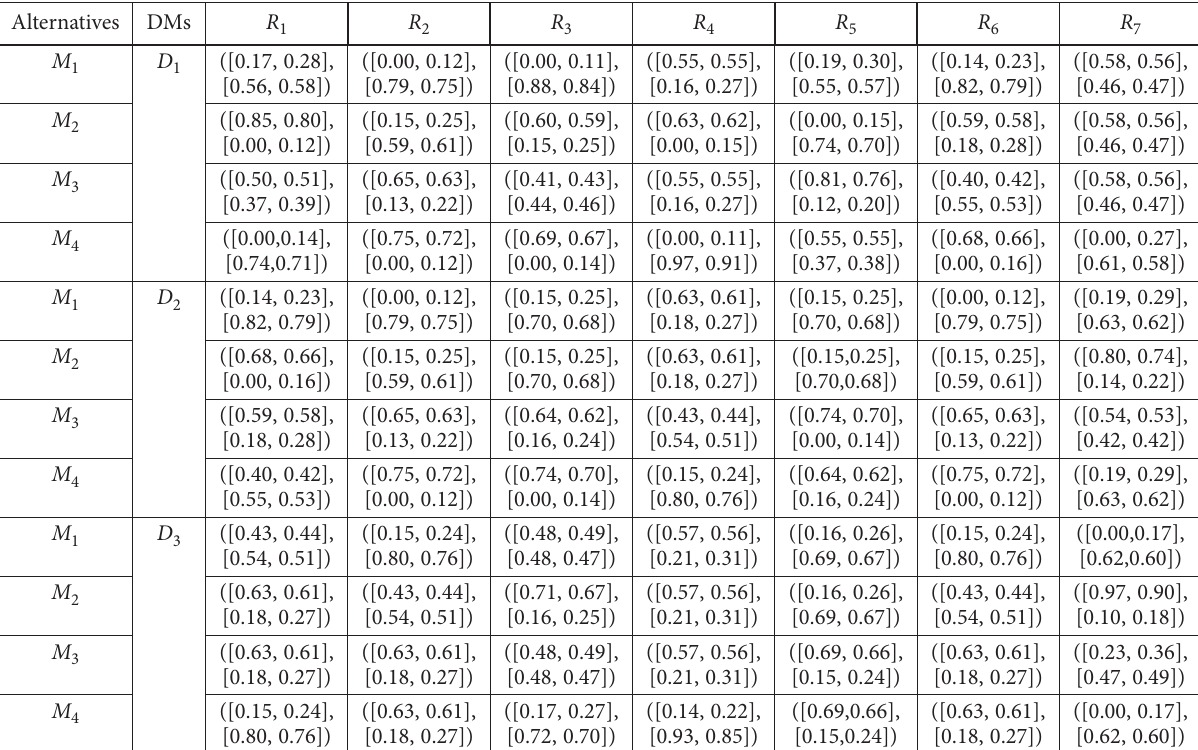
Table 5. Normalized decision matrix